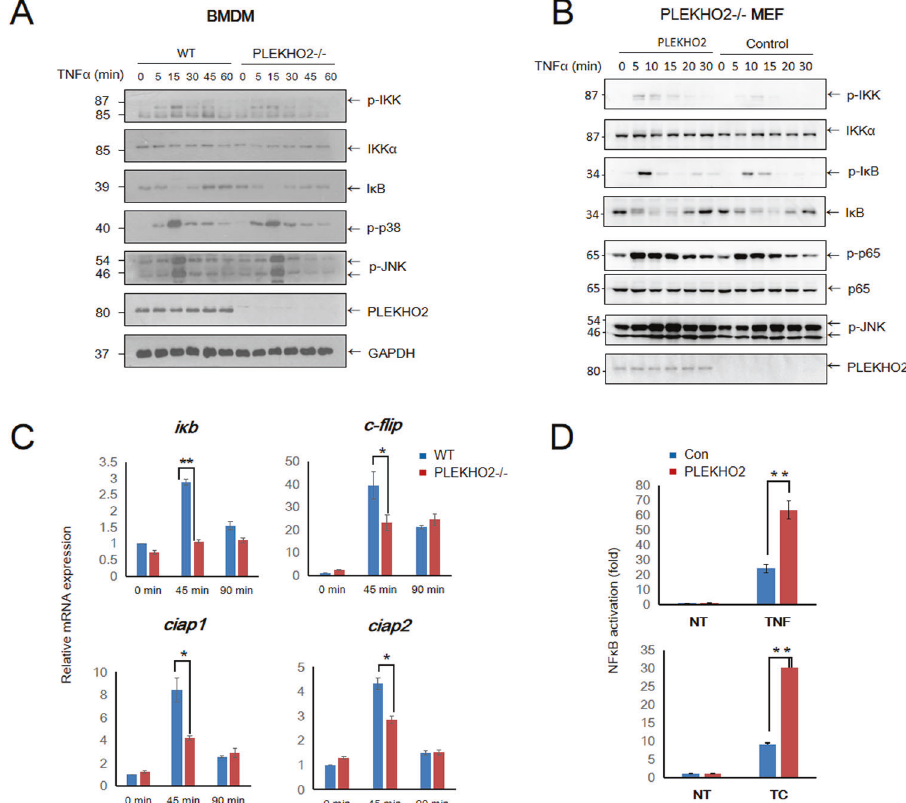
Fig. 4 PLEKHO2 promotes TNF α -induced NF- κ B activation. A , B WT and PLKEHO2 − / − BMDMs ( A ) or Control and PLEKHO2 reexpressed PLKEHO2 − / − MEFs ( B ) were treated with murine TNF α (20 ng/mL) for indicated periods of time, and cell lysates were probed with indicated antibodies. C mRNA expression of a panel of NF- κ B targeted genes in WT or PLKEHO2 − / − MEFs treated with TNF α (20 ng/mL) for indicated periods of time were determined by quantitative PCR (qPCR). D Reporter assay analysis of NF- κ B activation in 293T cells expressing PLEKHO2 or not, treated with TNF α (20 ng/mL) or TNF α plus CHX. Results are representative of at least three independent